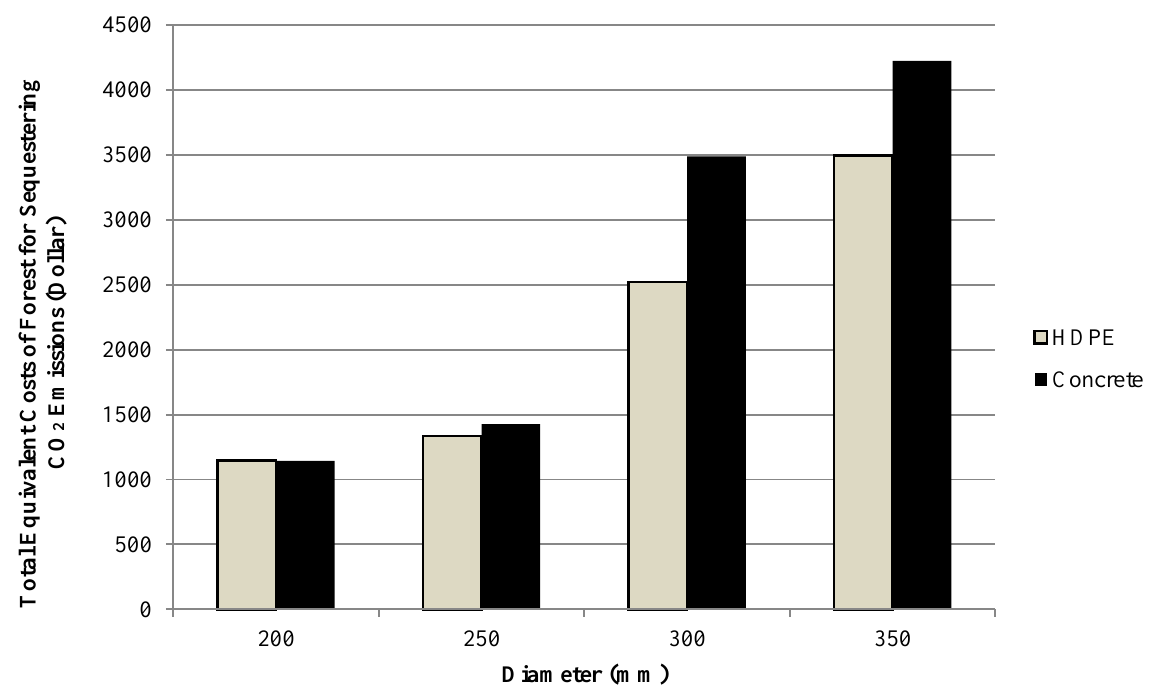
Fig. 4. Total equivalent cost of forest for sequestering CO 2 emissions* through the life cycle of all studied pipes * Note that GHGs other than carbon dioxide are emitted in relatively very small amounts during the life cycle of wastewater pipelines, and hence, the approximation of all GHGs to carbon dioxide, in this paper, for the sake of the conversion made in the figure, is justified to some